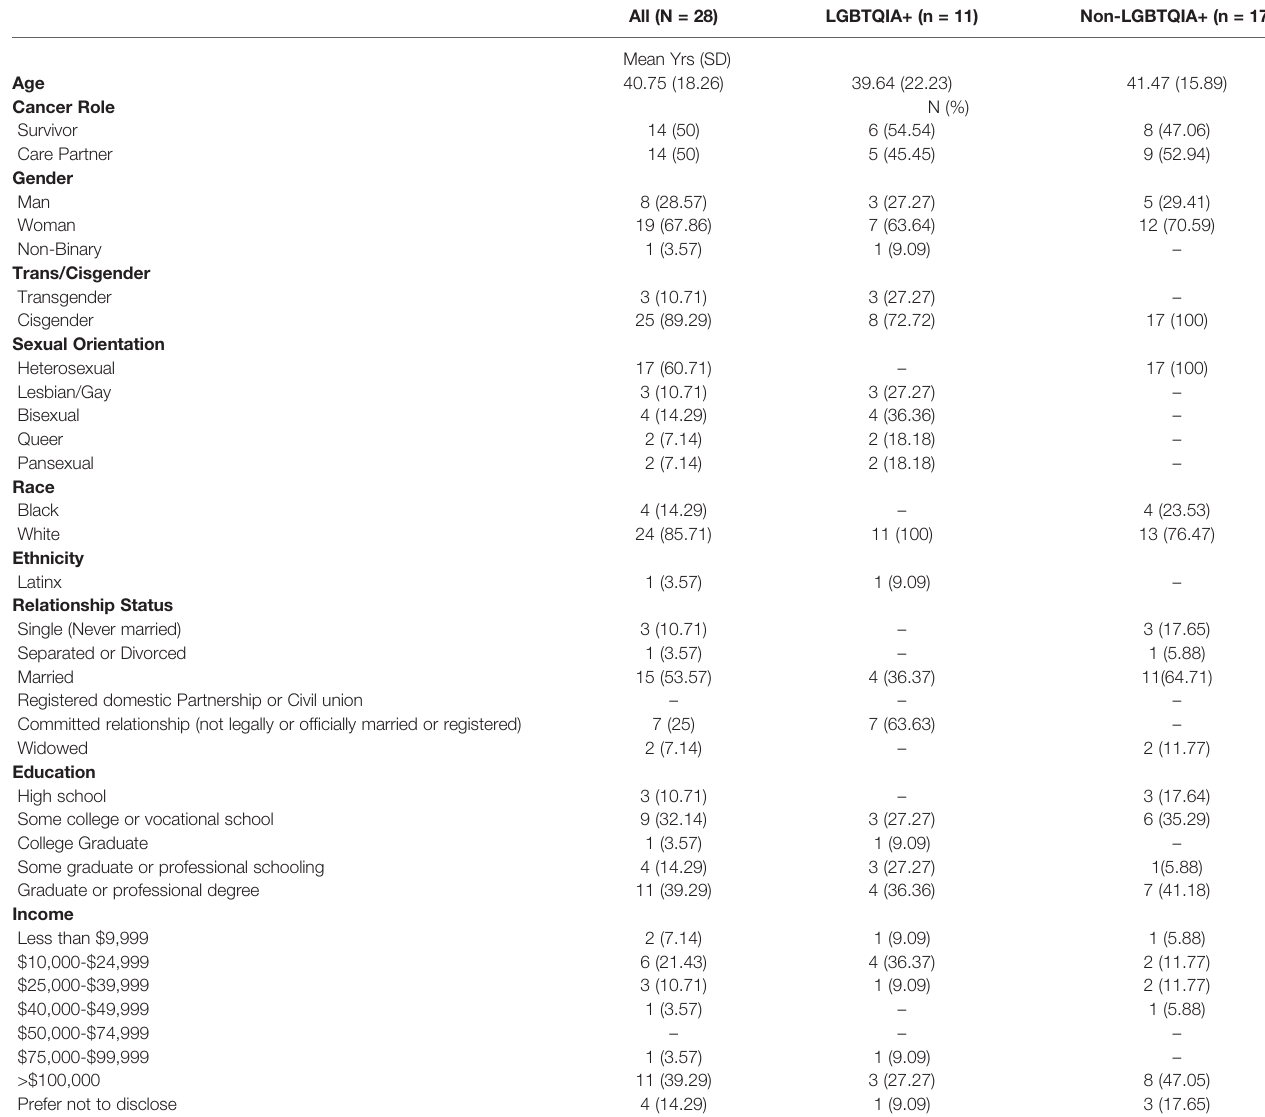
TABLE 1 | Participant